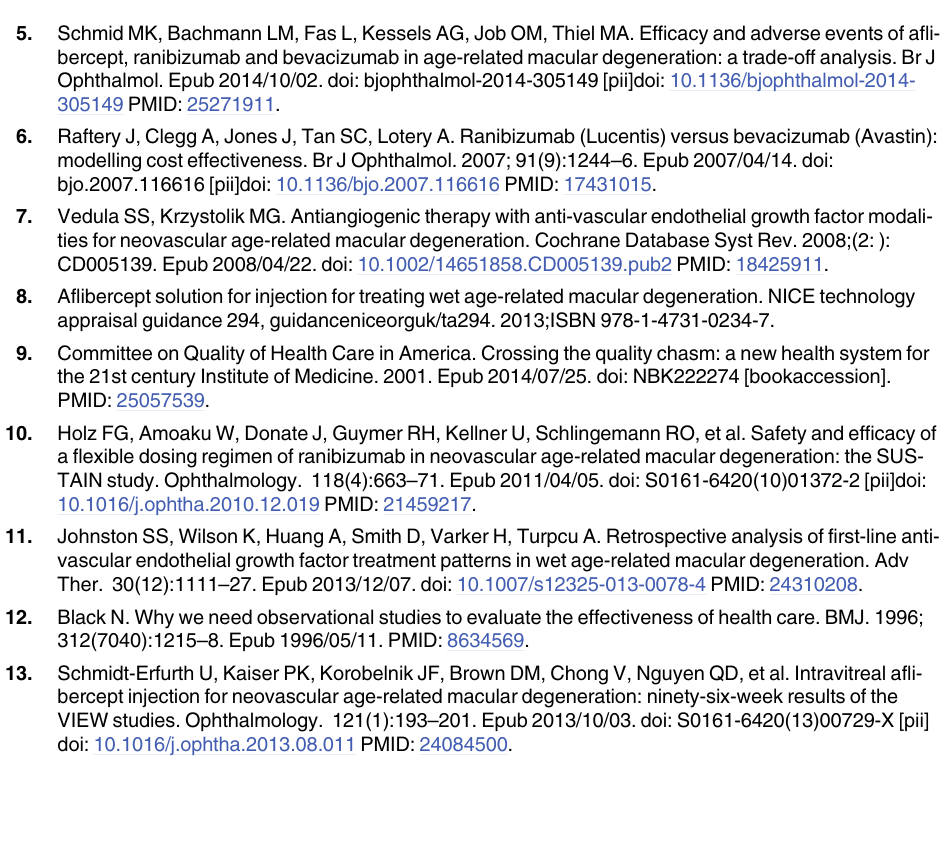
PLOS ONE | DOI:10.1371/journal.pone.0135050 August 4,